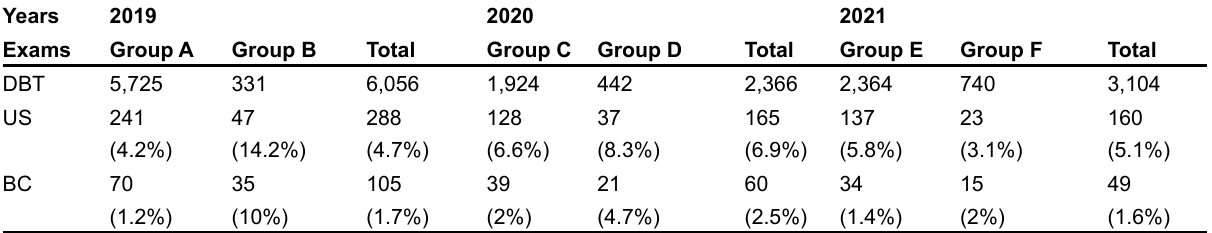
Table 2. Number of examinations performed in the years 2019, 2020, and 2021 in the Department of Diagnostic Senology, District 12, Caserta Local Health